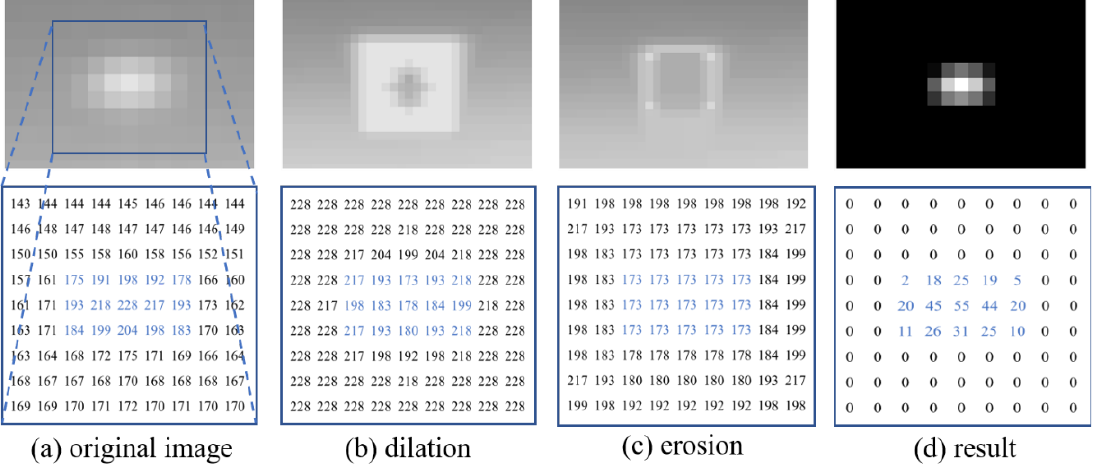
Figure 5. The matrix representations of the structuring elements.